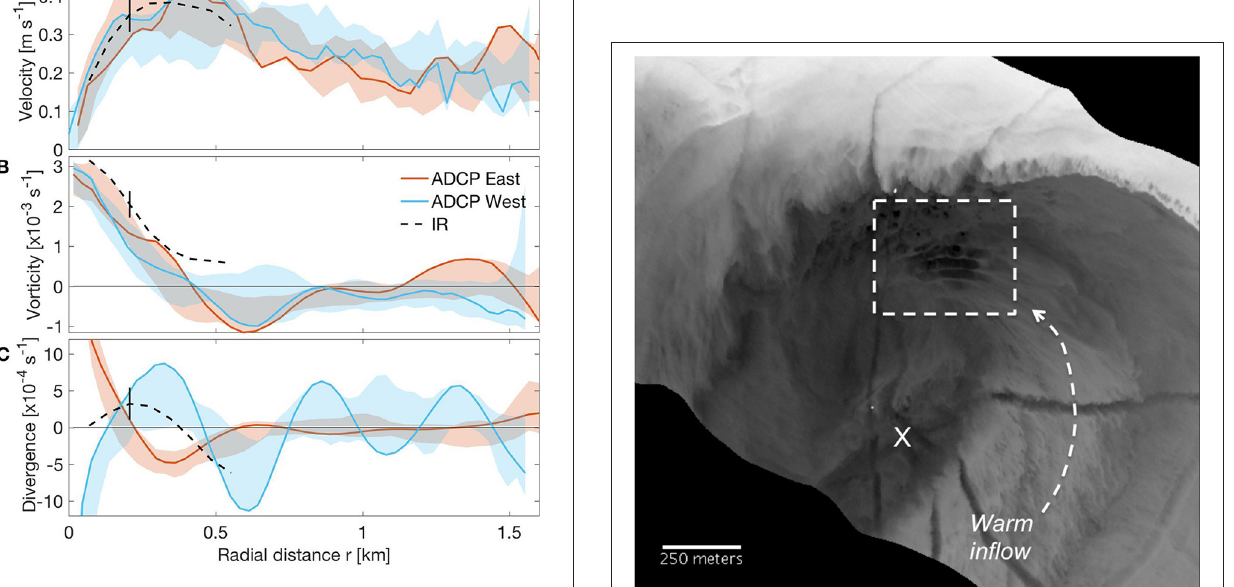
FIGURE 7 | Infrared imagery of an eddy sampled on 2 February, and which exhibits features similar to those in Figures 2 , 3 . An “X” indicates the approximate rotational center of the eddy; arrow indicates ingestion of warm water from the south; box highlights an area of regularly spaced bands of cold patches. Multiple, long dark signatures are cold wakes from two research boats, which themselves appear as bright objects in the image. Data were acquired 1.8h after that shown in Figure 1A